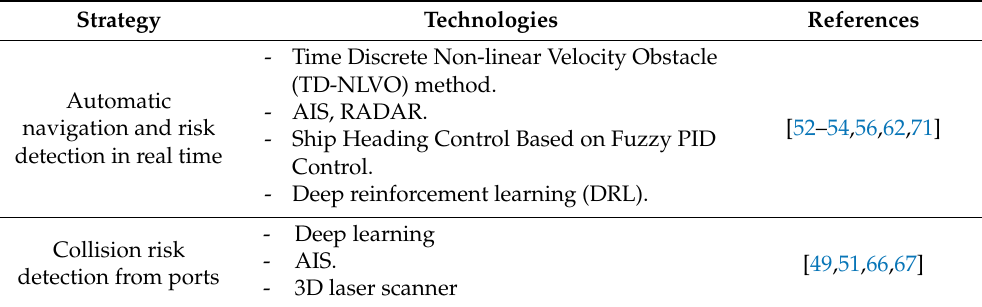
Table 6. Strategies detected in papers reviewed to face the problems of smart navigation.